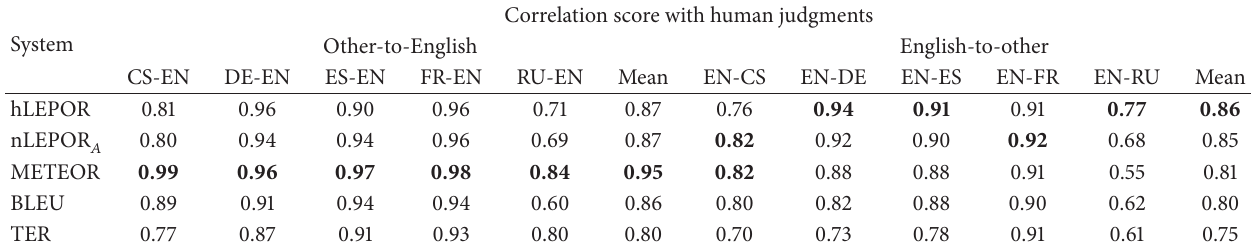
Table 10: The performances on WMT13 shared tasks using Pearson correlation. Correlation score with human judgments System Other-to-English English-to-other DE-EN